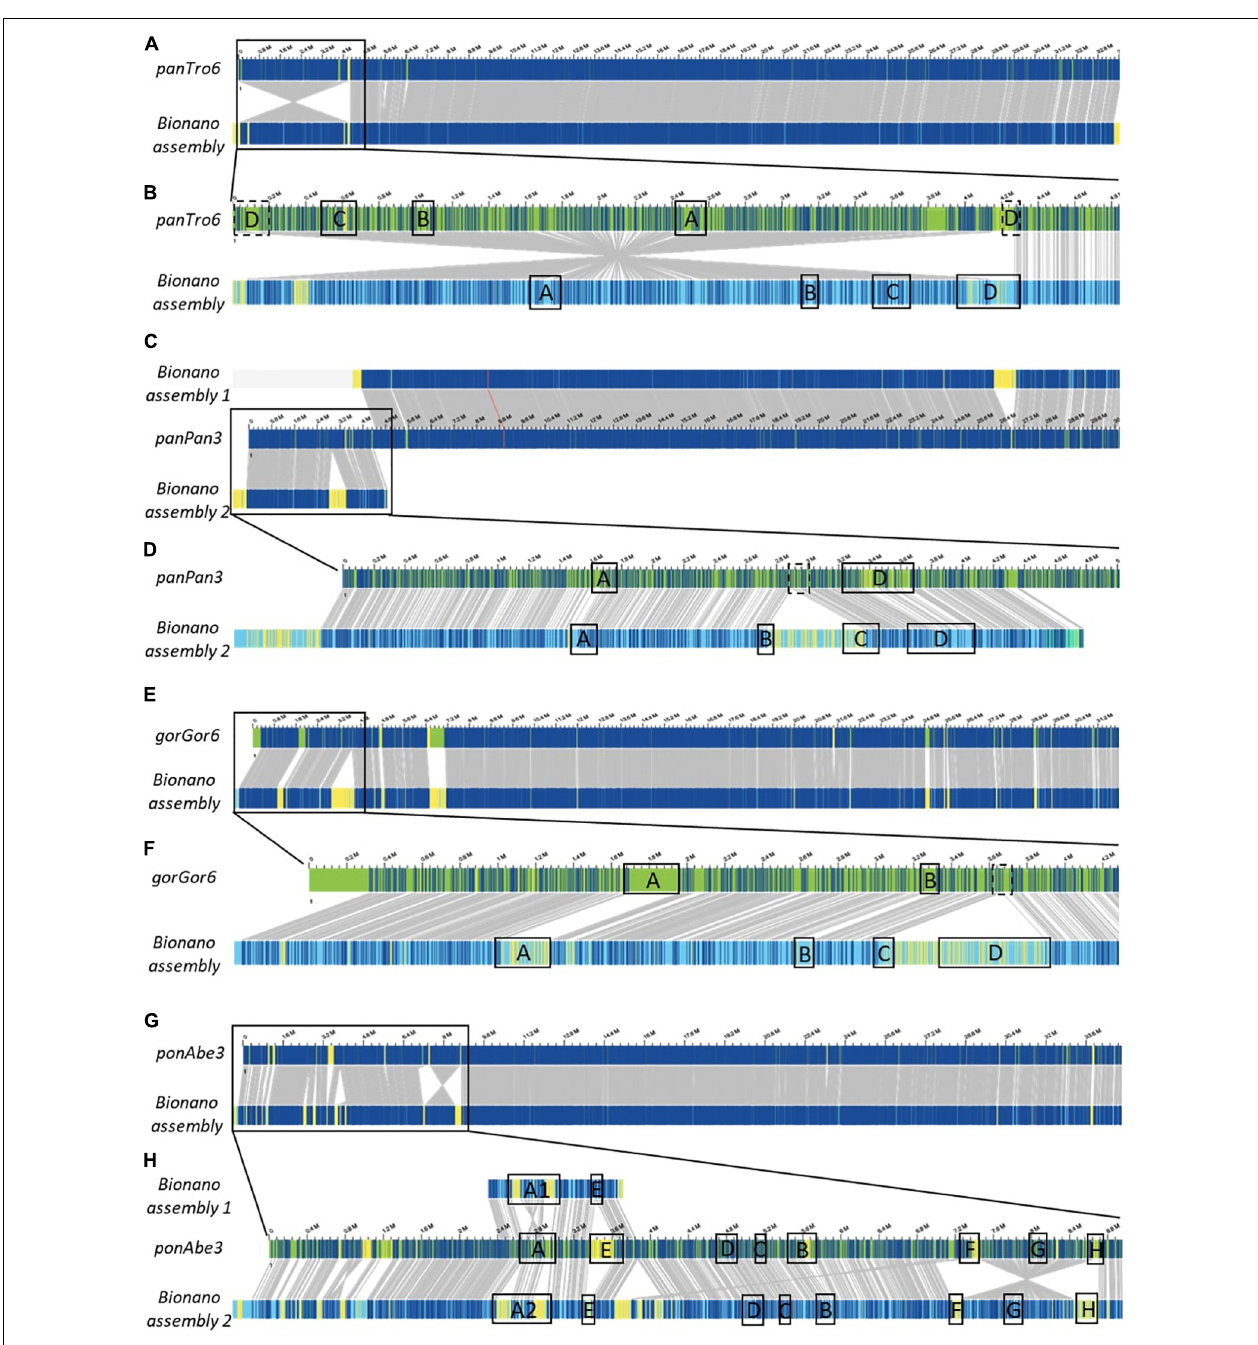
FIGURE 1 | Bionano optical mapping comparison to chromosome 22 reference of Great apes. Chromosome 22-wide comparisons between the Bionano assembly and the reference of the chimpanzee ( A , panTro6/Clint_PTRv2), bonobo ( C , panPan3/Mhudiblu_PPA_v0), gorilla ( E , gorGor6/Kamilah_GGO_v0), and orangutan ( G , ponAbe3/Susie_PABv2). A zoom to the 22q11.2 locus is depicted for the chimpanzee ( B , chr22:0-4,832,825), bonobo ( D , chr22:0-5,007,102), gorilla ( F , chr22:0-4,281,955), and orangutan ( H , chr22:0-8,985,772), where the LCR22 blocks are represented. Blue labels in the Bionano optical maps represent aligned labels, and yellow labels unaligned. These unaligned labels are non-similarities between the investigated genomes. They can be present either at the nucleotide level or in very complex regions as segmental duplications. Gray lines between the maps indicate orthologous loci.